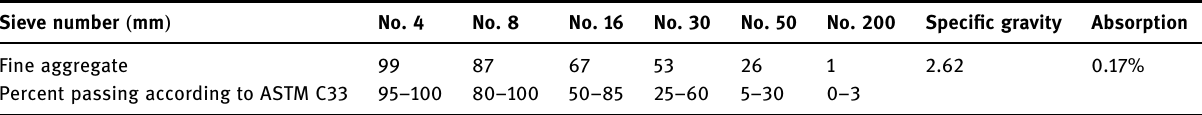
Table 2: The sieve analysis and physical properties of fi ne aggregates Sieve number ( mm